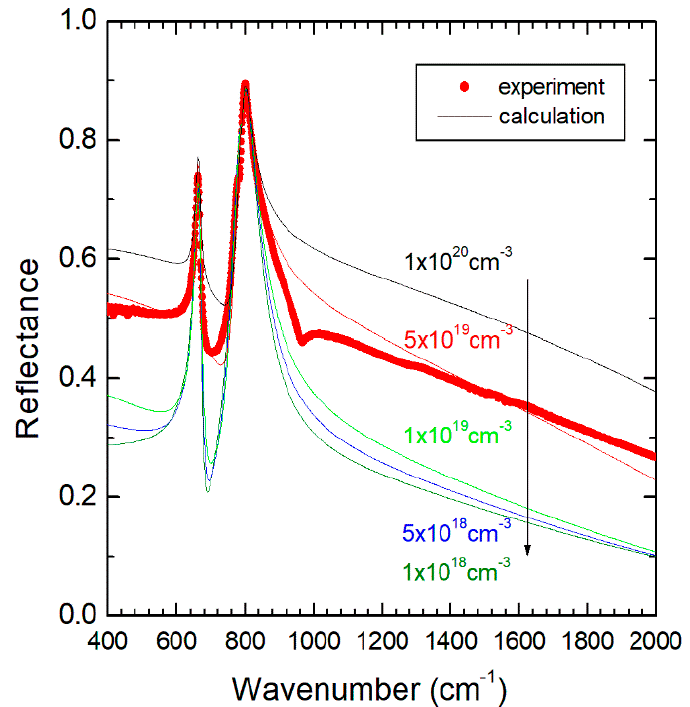
Figure 8. Experimental (red circle) and calculated (lines) infrared reflectance spectra of a 3C-SiC (270 nm)/AlN (100 nm)/Si heterostructure. The calculated spectra correspond to different doping levels, both in the SiC and AlN layers, ranging from 10 20 cm 3 down to 10 18 cm 3 (top to bottom). FTIR experimental reflectance spectra of materials or stacked heterostructures can be modeled by a classical dielectric model, where reflectance can be calculated from both the definition of the dielectric functions of each material present in the stack and the Fresnel coefficients at each interface [36,38]. The presence of free carriers (and, thus, doping) can significantly affect the reflectance spectrum and can be modeled by introducing a plasmon term (Drude term) to the dielectric function of the material. This Drude term is well separated from the lattice contribution (vibrations), which are described with a Lorentzian term. Thus, a qualitative assessment of a possible cross-doping effect could be carried out by comparing the experimental data with a simple dielectric calculation where we assumed different carrier concentrations. In the present work, a home-made code under a SCILAB environment [39] was used for calculating the dielectric–based reflectance of a 3C-SiC/AlN/Si heterostructure, taking as phonon parameters those reported in the literature [37,38] and considering a plasmon term, both in the SiC and in the AlN layers, as variable parameters, ranging from 200 to 2200 cm − 1 for targeting carriers concentrations of 10 18 , 5 × 10 18 , 10 19 , 5 × 10 19 , and 10 20 cm − 3 . In addition to the experimental data, Figure 8 shows the calculated reflectance spectra obtained with these different doping levels. The background, against which the SiC and AlN phonon-related peaks are observed, was soundly enhanced by the introduction of plasmon terms. For obtaining a qualitatively good agreement between the experiment and calculation, a carrier concentration roughly in the mid-10 19 cm − 3 was required. Obviously, our approach remains a rough estimation, as our model cannot take into account the presence of carrier concentration gradients at the interfaces or inside layers. From an experimental point of view, these gradients are very likely to occur, as cross-doping should generate diffusion mechanisms. At